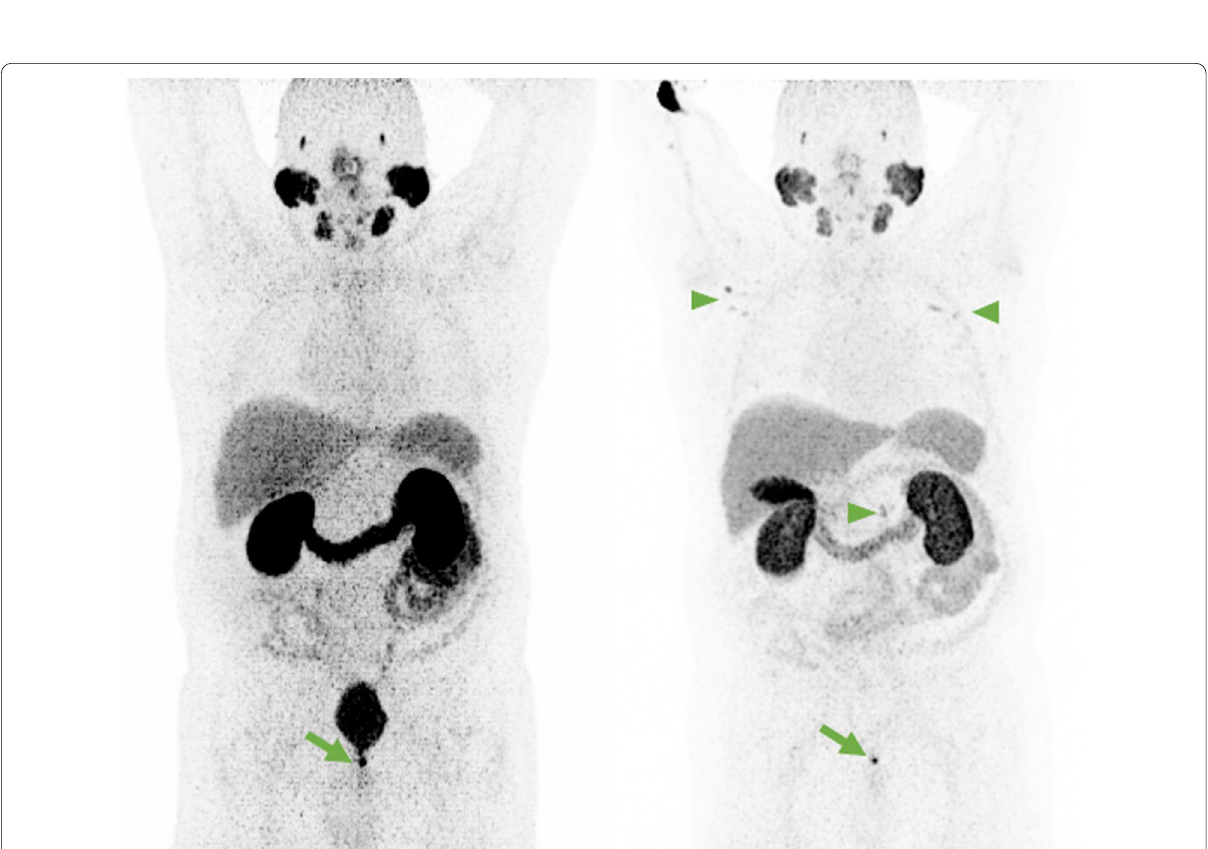
Fig. 9 MIP of [ 68 Ga]-Ga-PSMA-11 and [ 18 F]-F-PSMA-1007 PET: Beside the concordant local recurrence in the left prostate bed (arrow), there is unspecific oligofocal uptake in the rip thorax, lymphonodally in the right axilla, the coeliac ganglia (arrow heads) and the gall